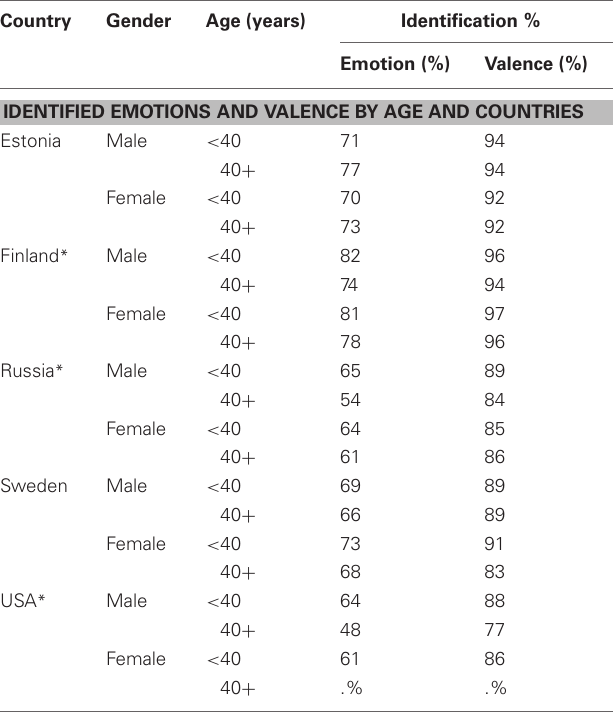
Table 2 | Percentages and significance for identified emotions and valence by age and